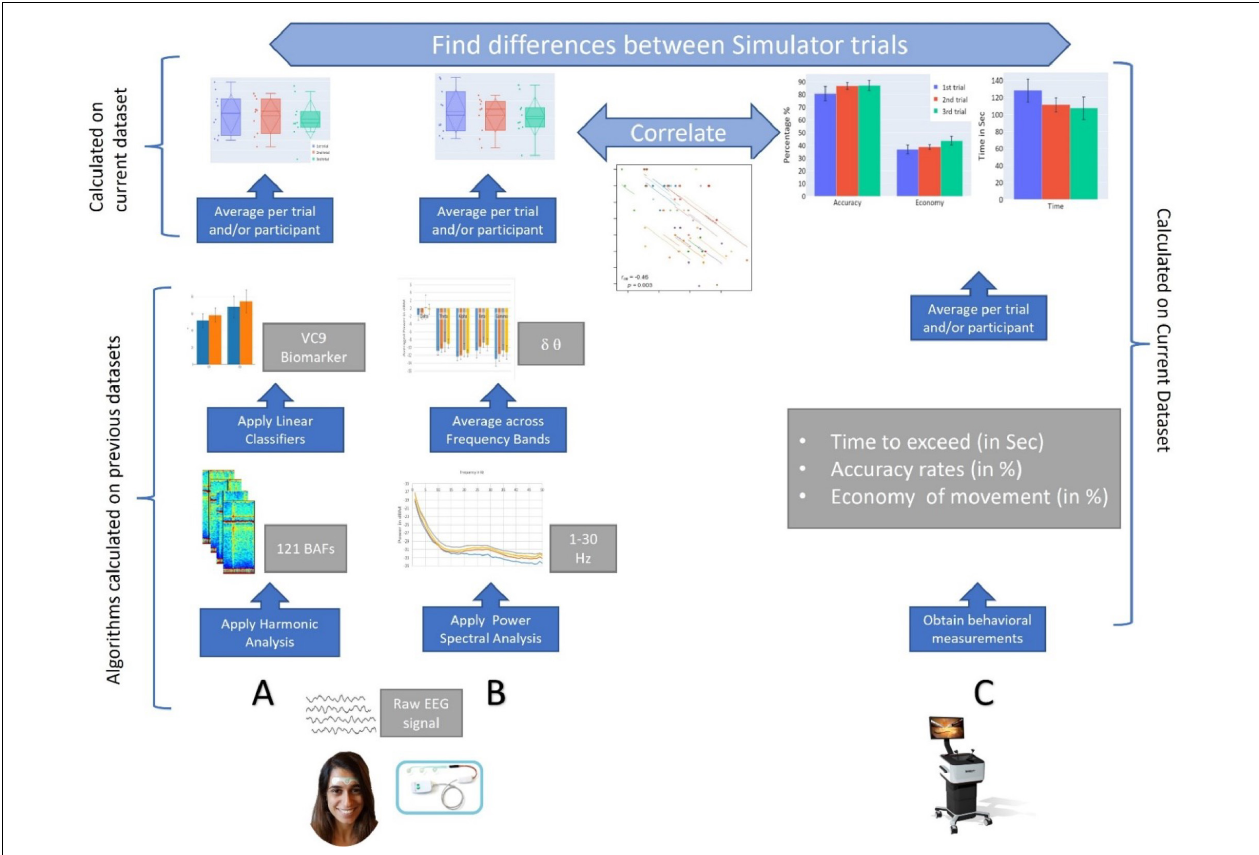
FIGURE 1 | A graphical representation of the study. (A) EEG data are recorded via a single channel using a three-electrode forehead patch by an Aurora EEG system while participants perform the simulator task. Data are pre-processed by a predefined set of wavelet packet atoms to produce 121 Brain Activity Features (BAFs). The BAFs are passed through linear models, which were pretrained on external data, to form a higher-level biomarker, VC9. Then, VC9 activity is averaged per trial and participant to find differences between simulator trials. (B) From the raw EEG data, power spectral density analysis is applied to find energy representation (in dB) produced for 1–50 Hz. The power density per Hz is averaged over frequency bands. Theta and delta activity are averaged per trial and participant to find differences between simulator trials. (C) Behavioral data are obtained from the Simbionix LAP MENTOR TM (i.e., time, accuracy, and economy of movement). These are averaged per trial and participant to find differences between simulator trials. Finally, correlations are calculated between EEG features (i.e., VC9, theta, and delta bands) and behavioral performance (time, accuracy, and economy of